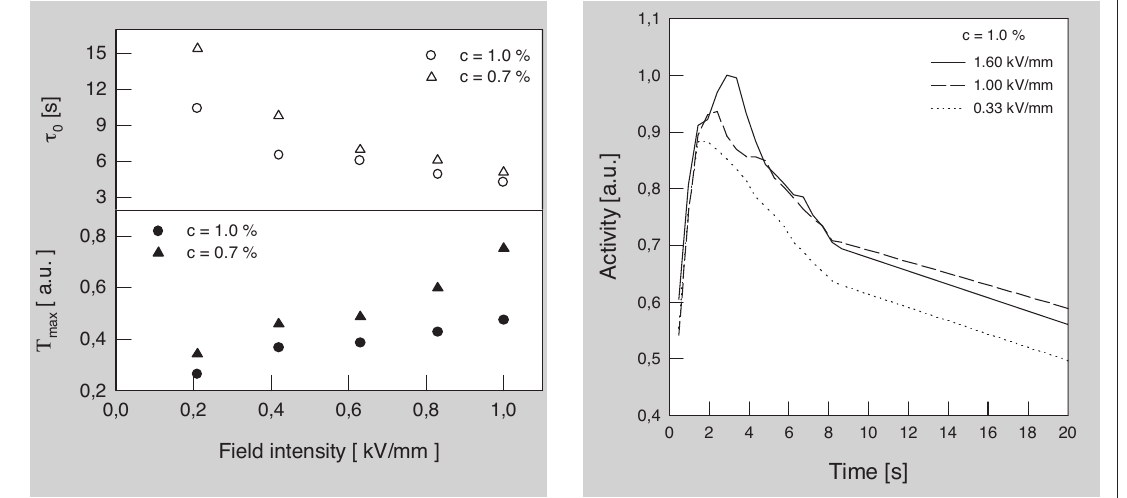
Figure 8 (left): Dependence of maximum transmittance and time constant on the electrical field intensity, with the concentration as a parameter. Figure 9 (right):S peckle Activity as a function of time, for the 1% concentra- tion sample, subjected to several field